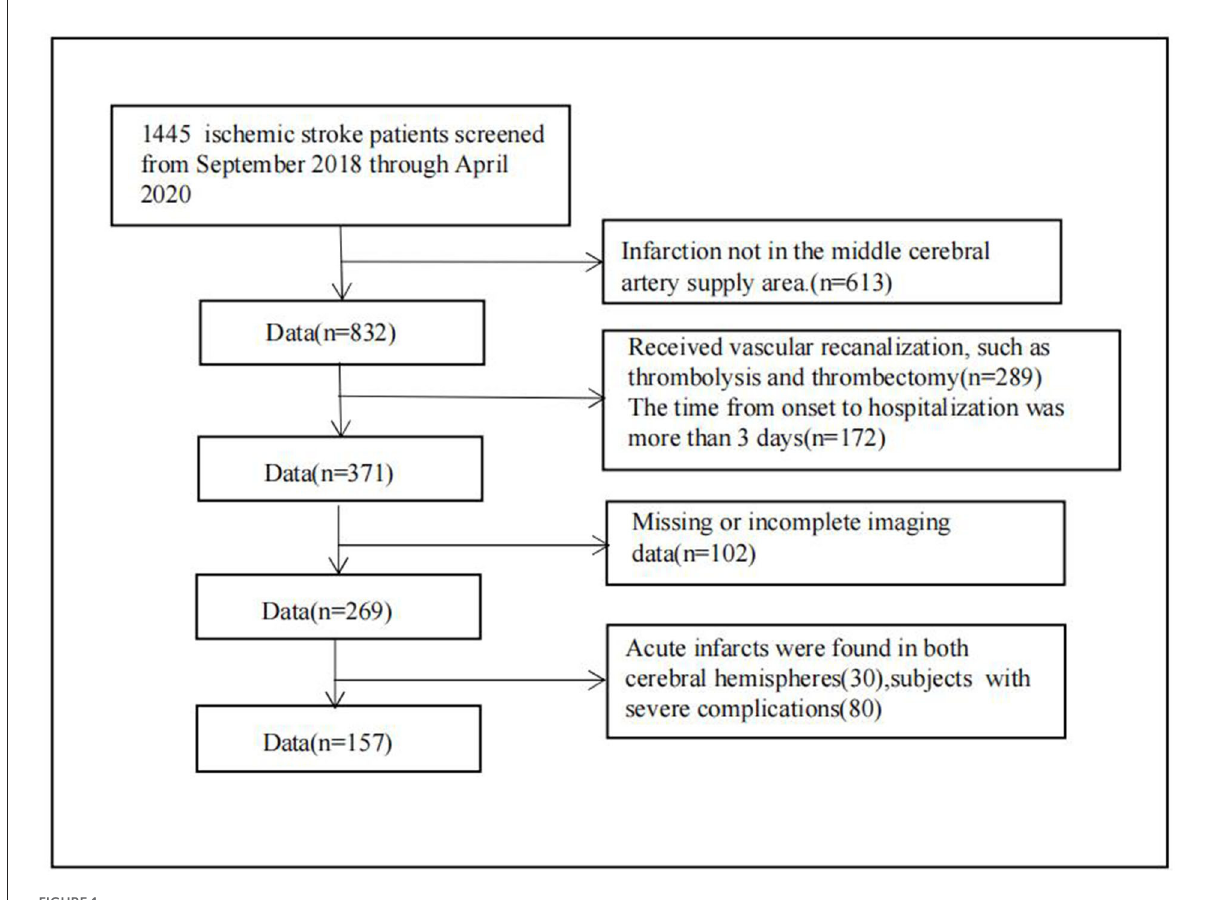
FIGURE1 Flow chart of the systematic review screening